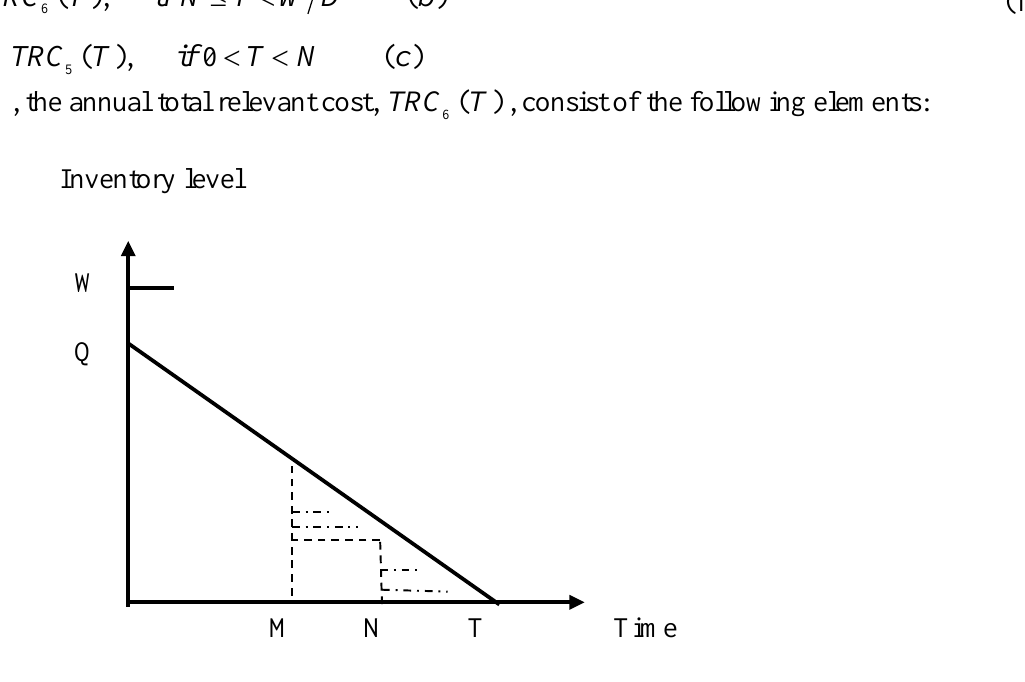
Fig. 3. The inventory level and the total saved amount of interest payable